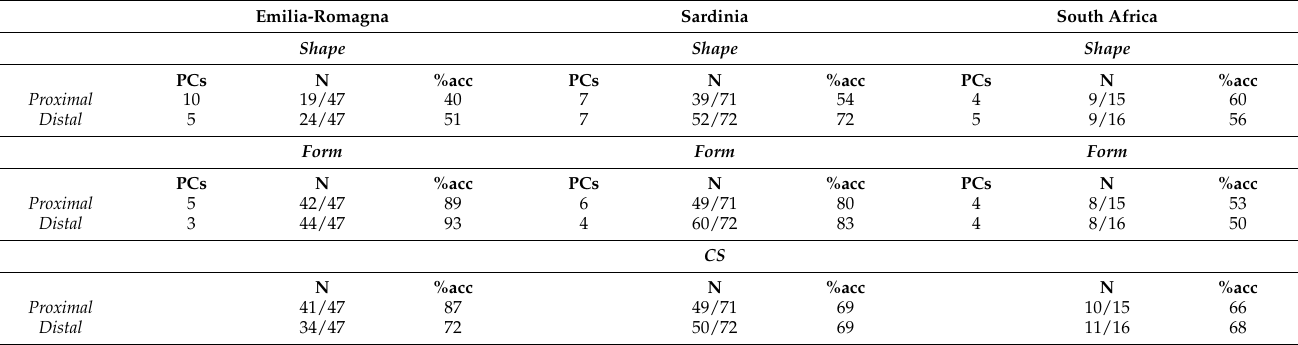
Table 6. Sex determination accuracy percentages obtained by cross-validation LDA on each popula- tion for shape and form PC scores (PCs) and centroid size (CS) of proximal and distal